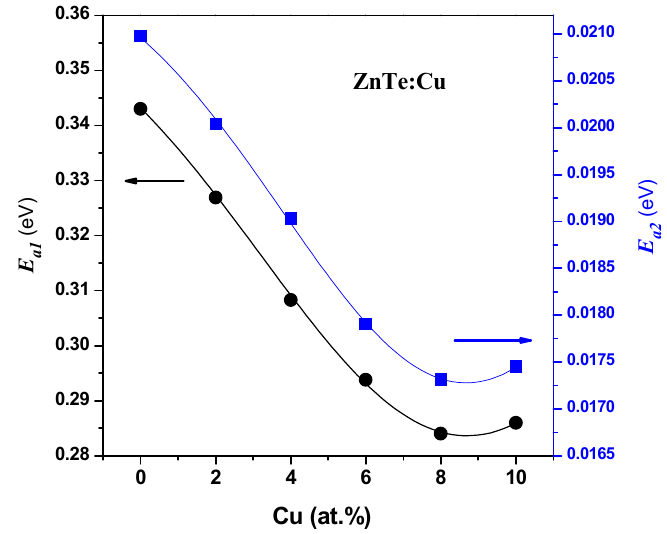
Figure 15. Dependence of activation energies on Cu content (at.%).